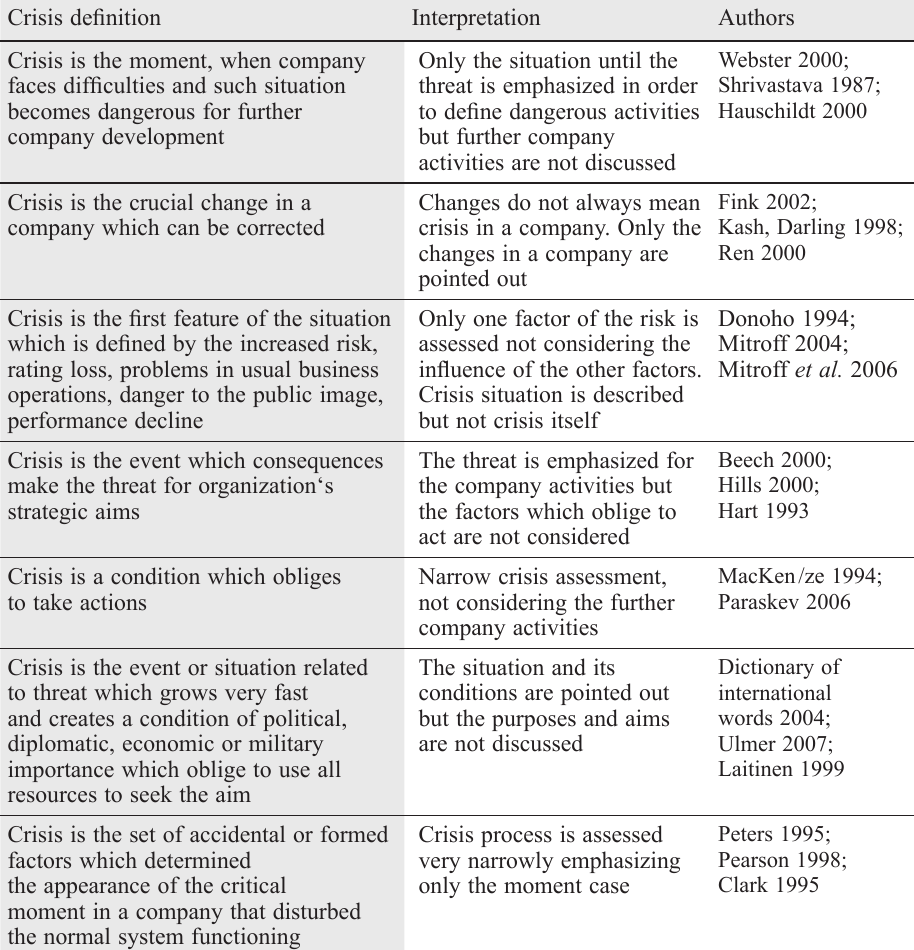
Table 2. Conceptualization of crisis de fi nitions (modi fi ed by the